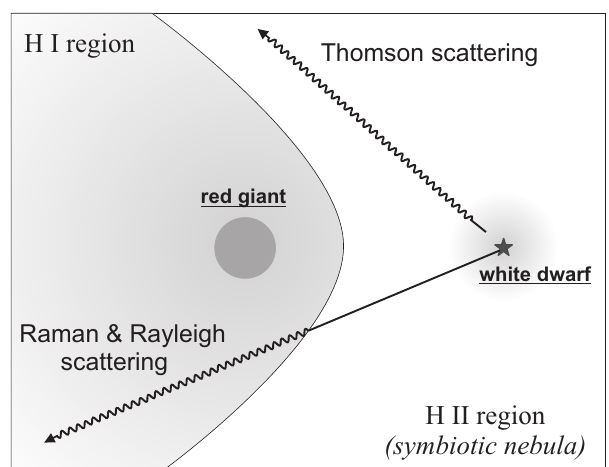
Figure 1: Simplified ionization structure of a symbi- otic star. While the radiation from emission region in a vicinity of the white dwarf is Thomson scattered in ionized part of the circumstellar environment, in the neutral part it can be Raman or Rayleigh